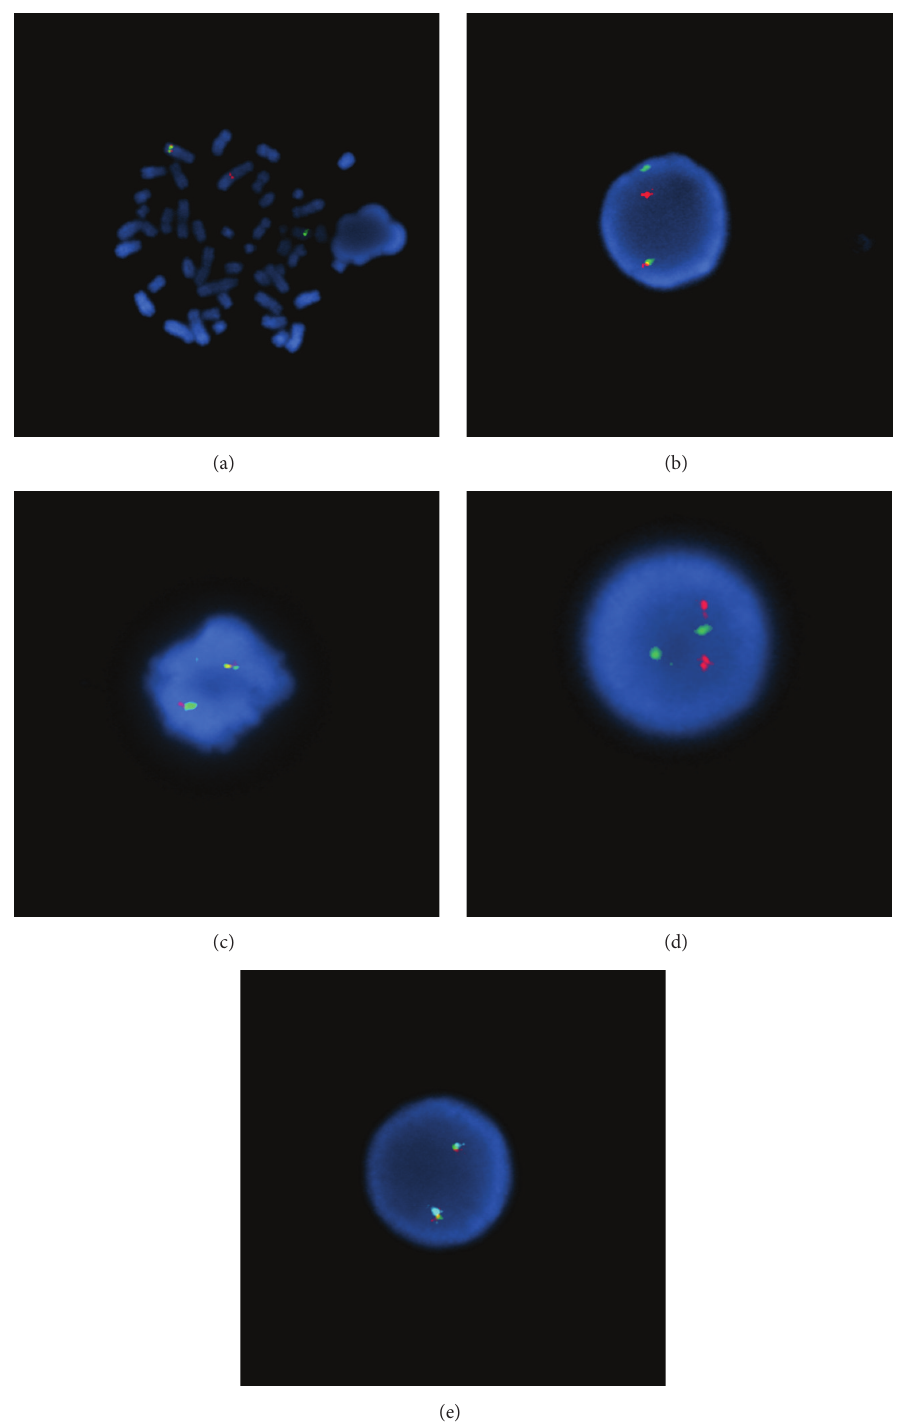
Figure 3: Fluorescence in situ hybridization (FISH) studies. (a) PDGFRB Breakapart Probe (Cytocell, Tarrytown, NY), metaphase illustrating the telomeric green probe translocated to shorter chromosome 4 and the centromeric red probe remaining on elongated chromosome 5; (b) interphase cell illustrating PDGFRB rearrangement, separation of PDGFRB Breakapart Probe; (c) FGFR1 Breakapart/Amplification Probe (Cytocell), normal signal pattern; (d) BCR/ABL1 Translocation, Dual Fusion Probe (Cytocell), normal signal pattern; (e) Vysis (Abbott Molecular, Abbott Park, Illinois) LSI 4q12 Tricolor, Rearrangement Probe, 4q12 (LNX, orange; SCFD2, green; PDGFRA/KIT, aqua), normal signal